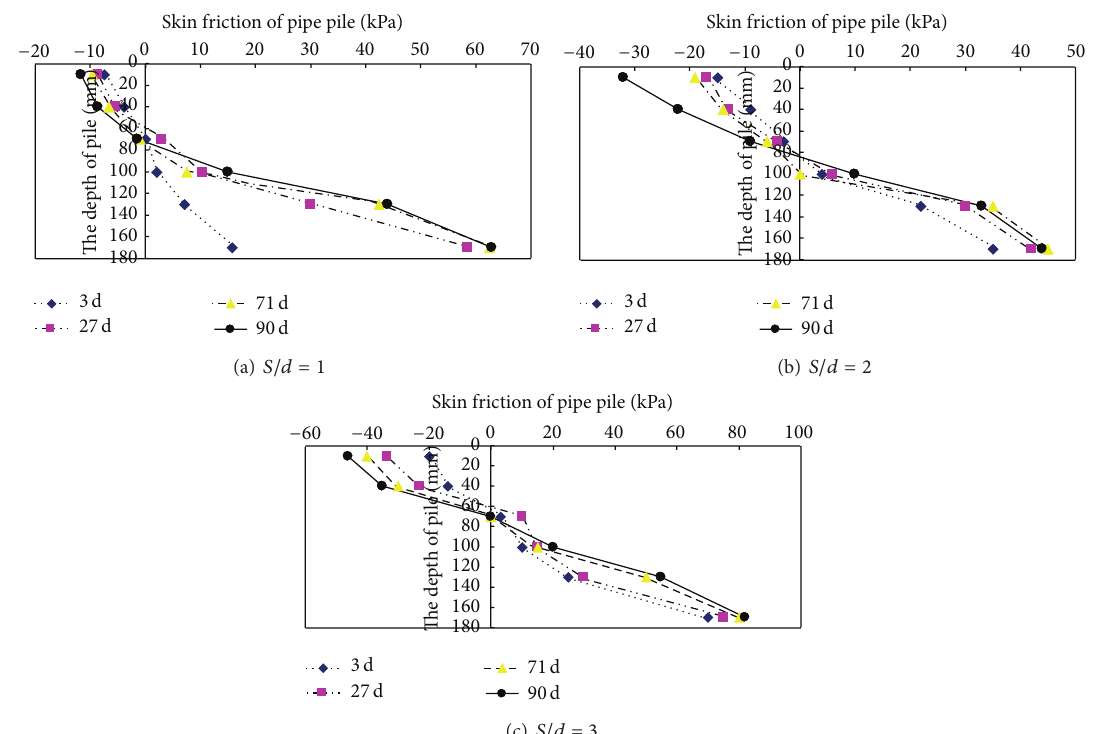
Figure 11: Skin friction distributions along the pile depth during water log